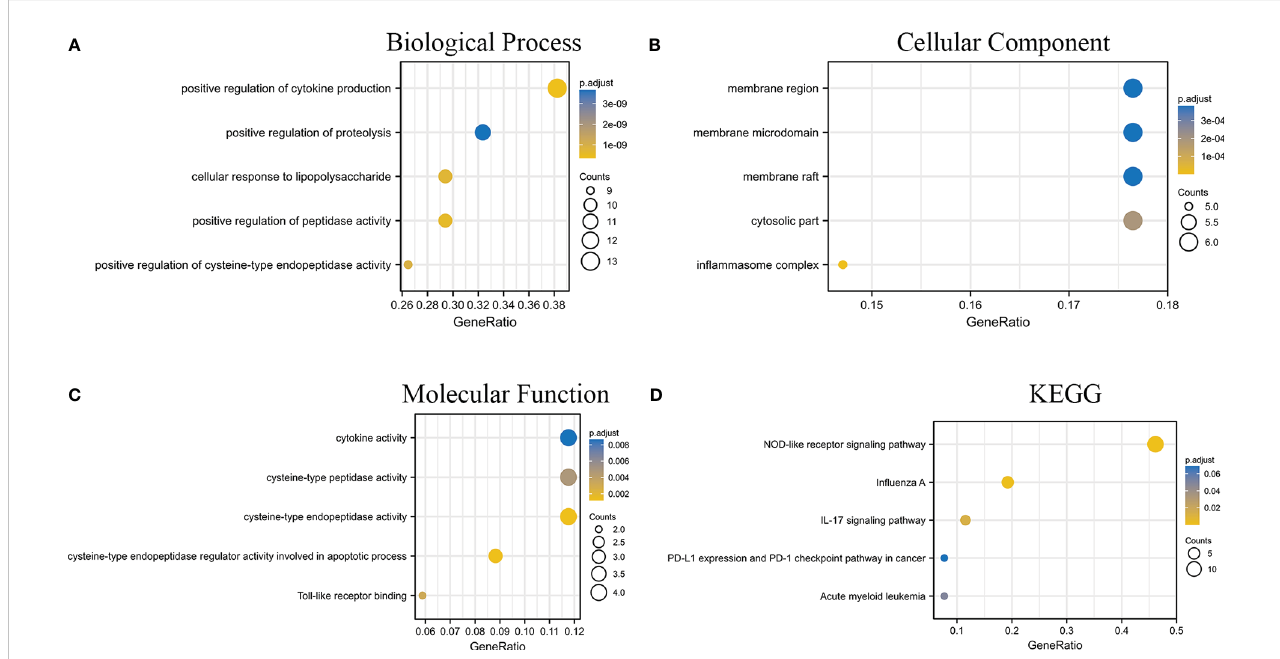
FIGURE 2 GO and KEGG enrichment analysis results of intersecting genes. (A – C) are the analysis results of BP, CC, and MF in GO, respectively. (D) is the result of the KEGG enrichment